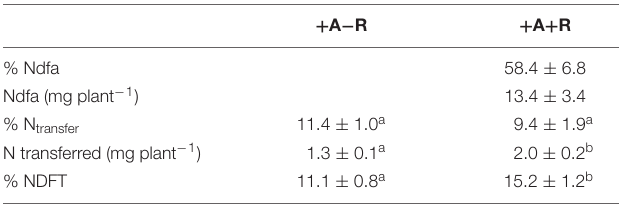
TABLE 4 | N transfer and proportion of N fixed by soybean as affected by inoculation in a growth chamber labeling